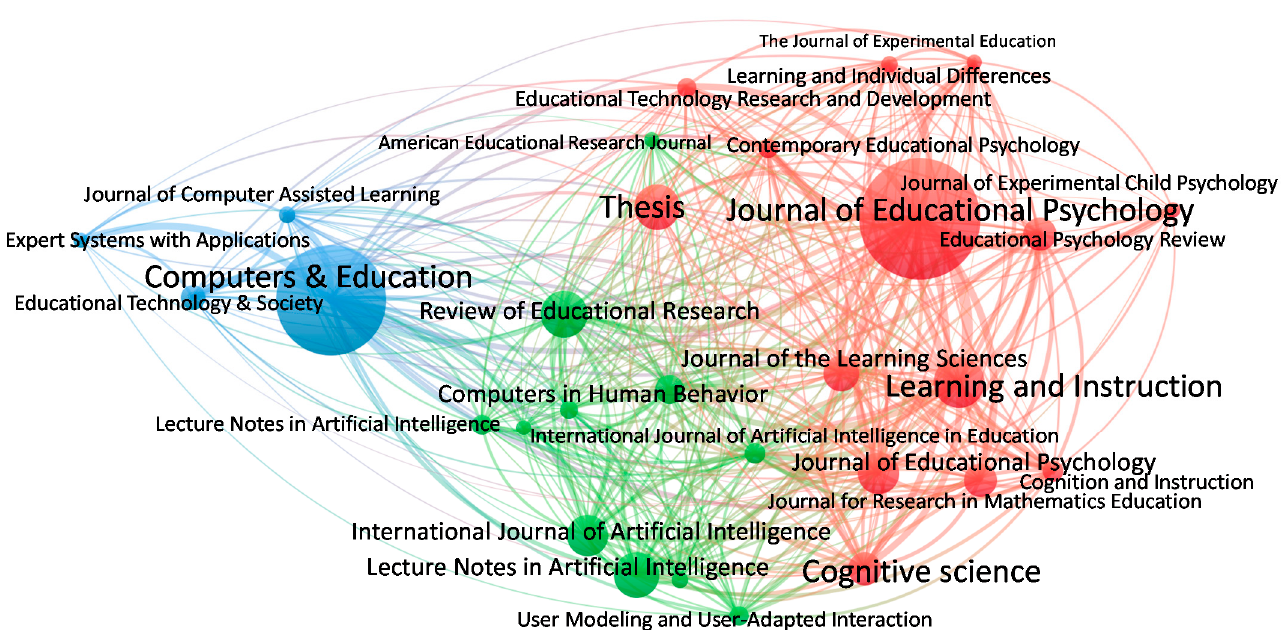
Figure 5. The most cited journals (co-citation analysis).